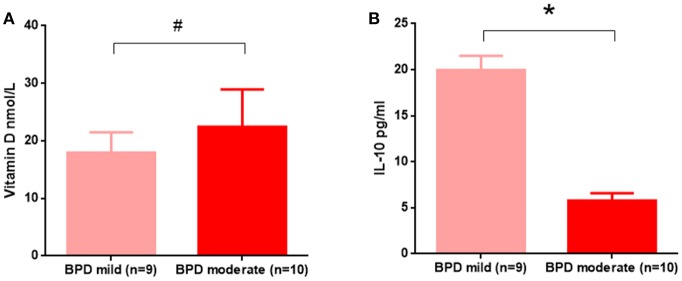
In the 24 h samples, IL-10, but not vitamin D, contributed to BPD disease severity. (A) Vitamin D levels were not significantly different between mild and moderate BPD infants (p = 0.5392); (B) Compared to mild BPD infants, IL-10 was significantly decreased in moderate BPD neonates (p = 0.0344). Nine BPD patients with mild disease and 10 BPD patients with moderate disease were analyzed in this study. #p > 0.05; *p < 0.05.